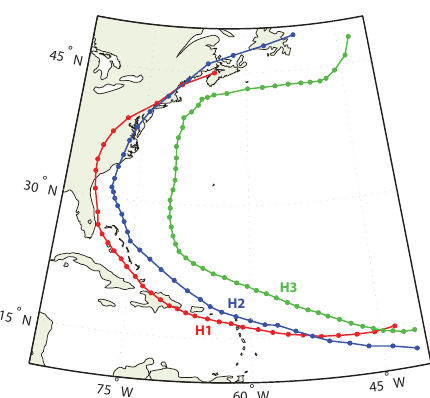
Figure 1: Trajectories of hurricanes distinguished by context: tropical storm Chris 1988 (red), hurricane Bertha 1996 (blue), and Edouard 1996